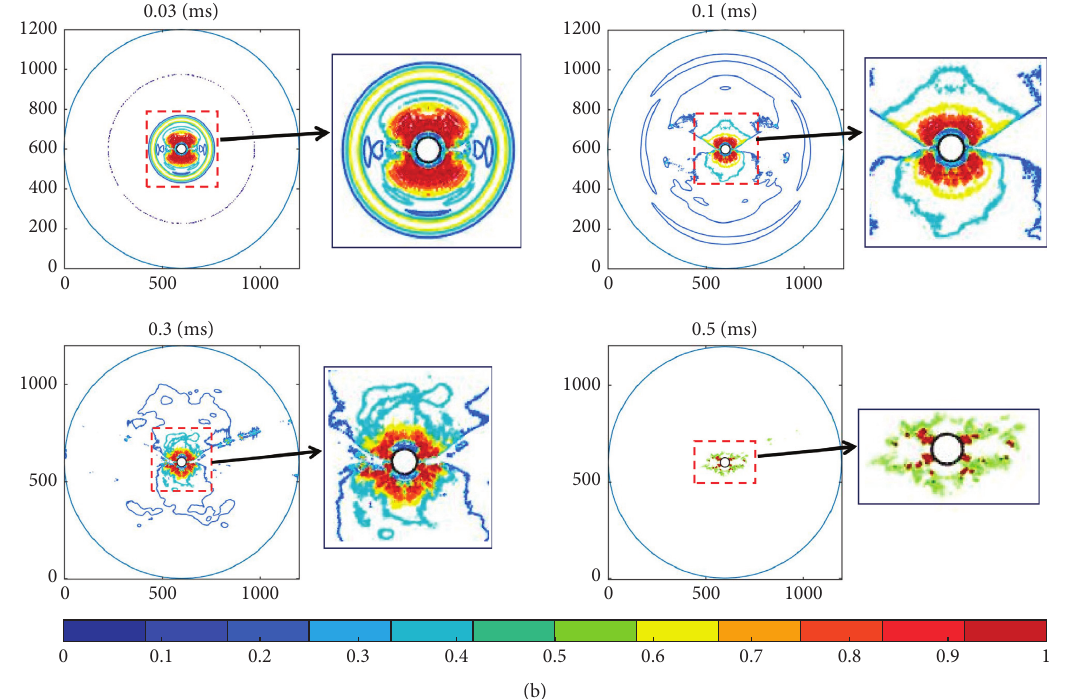
Figure 8: Damage evaluation and effective stress evaluation for 35 ° shaped energy angle blasting. (a) Development process of 35 ° shaped energy angle damage. (b) The development process of equivalent stress of 35 ° degree shaped energy angle